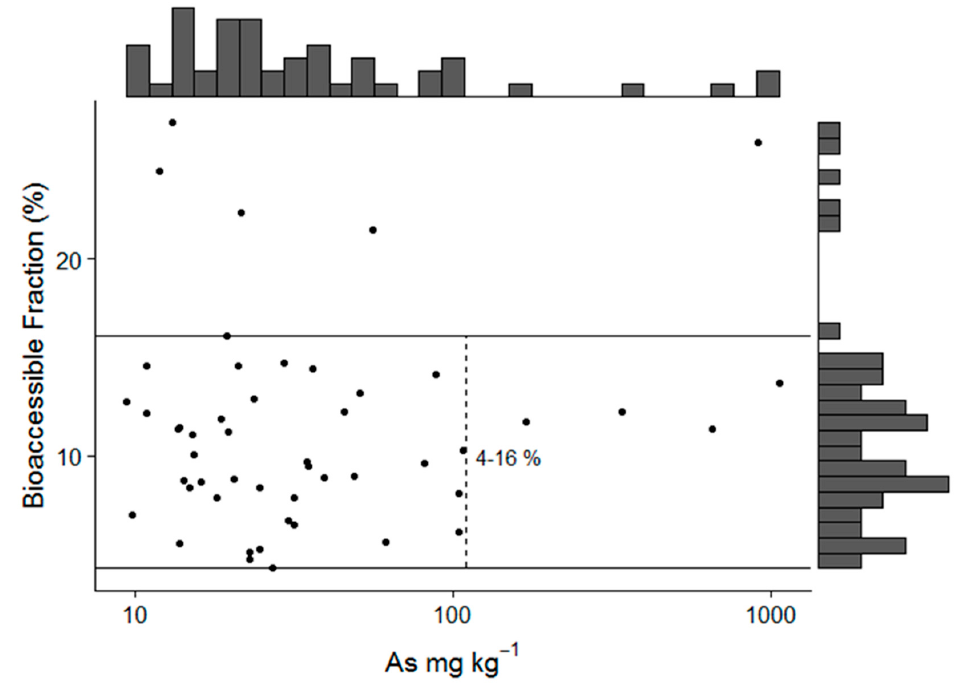
Figure 7. Relationship between total As in the <250 µm particle size and the bioaccessible As fraction. The histograms on plot show the separate marginal distributions of the bioaccessible As fraction and the total As in the selected soils.